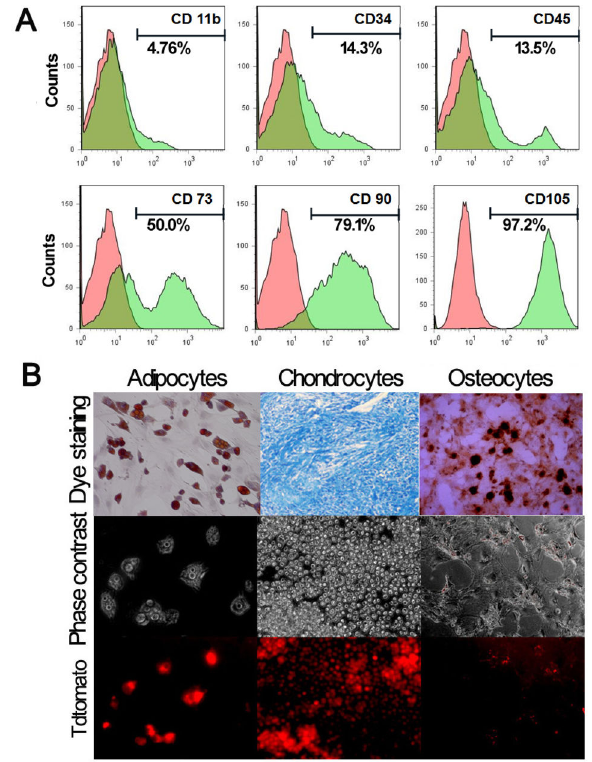
Figure 5. Characterization of MSCs. (A) FACS analysis of the immunophenotype profile of MSCs. MSCs are uniformly positive for extracellular matrix protein CD90, endothelial cells antigen CD105, and low-level hematopoietic progenitor cell marker CD34 and leukocyte common antigen, but are negative for macrophages monocyte antigen CD11b. (B) MSCs can differentiate into adipocytes, chondrocytes and osteocytes in vitro as assessed by oil Sudan III, alcian blue or alizarin S staining. showed fluorescent signal after